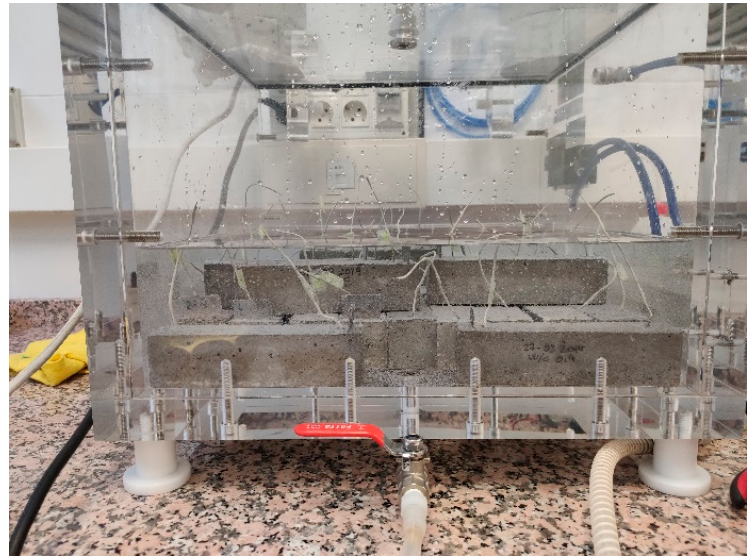
Figure 3. Samples immersed in the vacuum chamber.